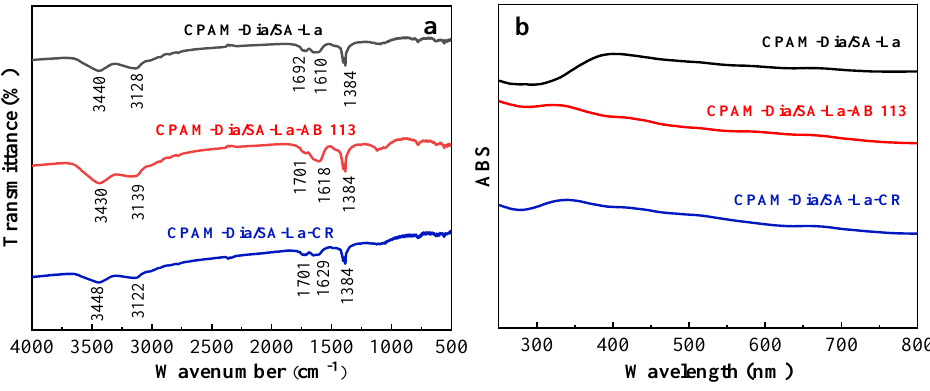
Figure 5. FT − IR ( a ) and UV − Vis ( b ) spectra of CPAM-Dia/SA-La before and after dye Figure 5. FT−IR ( a ) and UV−Vis ( b ) spectra of CPAM-Dia/SA-La before and after dye adsorption.